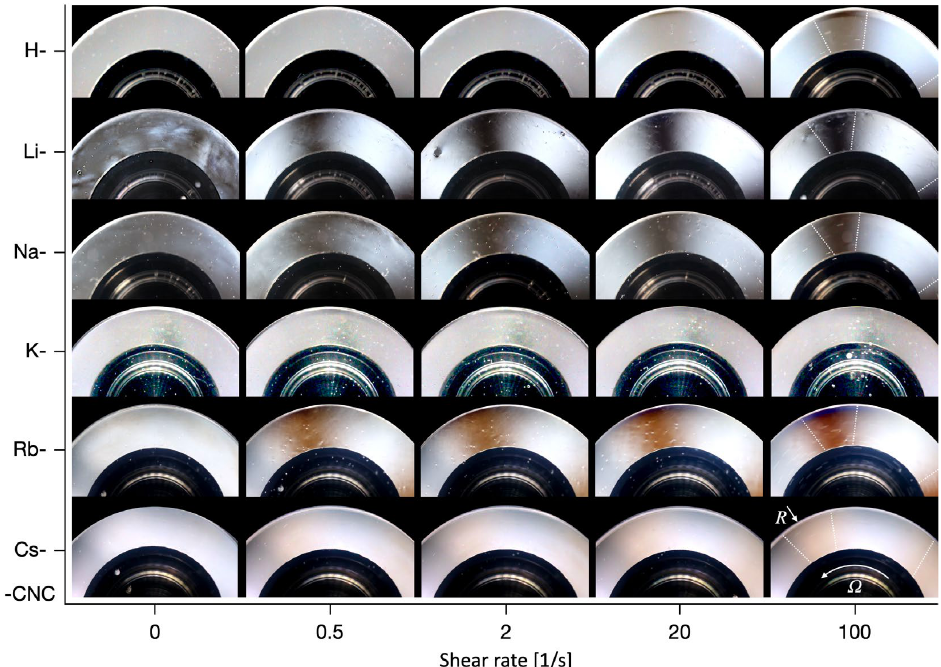
Figure 6. Birefringence patterns of CNC suspensions with respect to shear rate corresponding to the steady shear viscosity data in Figure 5. The white dotted lines at 100 s − 1 are meant to approximate the location of the Maltese-cross fringes. The visualization background has been artificially replaced (black regions) to enhance contrast.